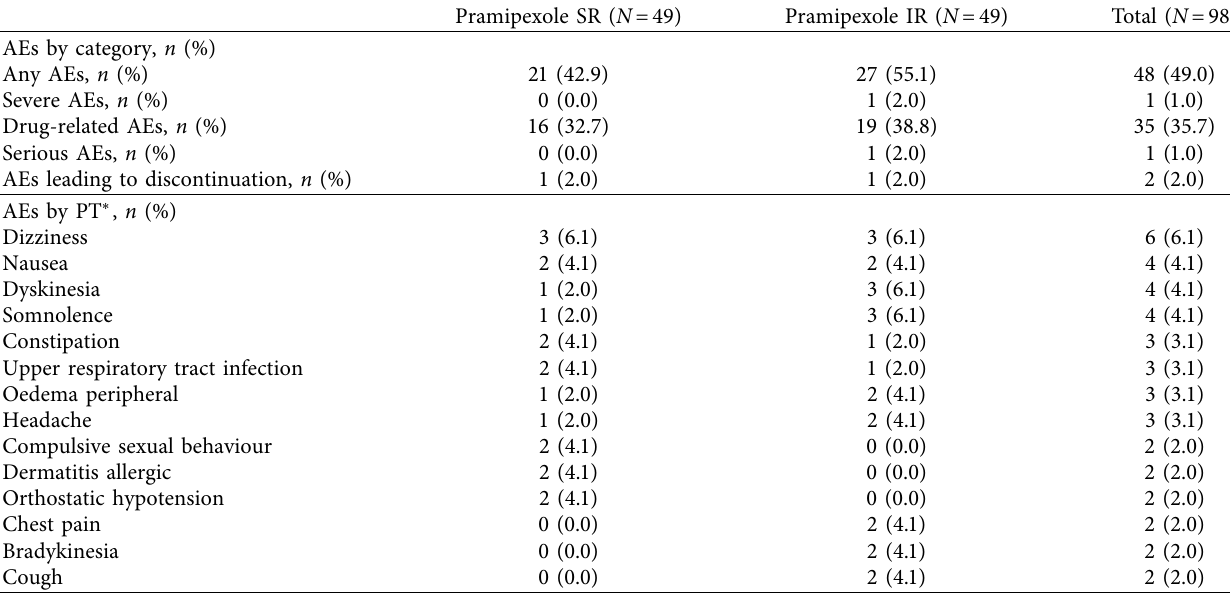
Table 4: Overall summary of safety